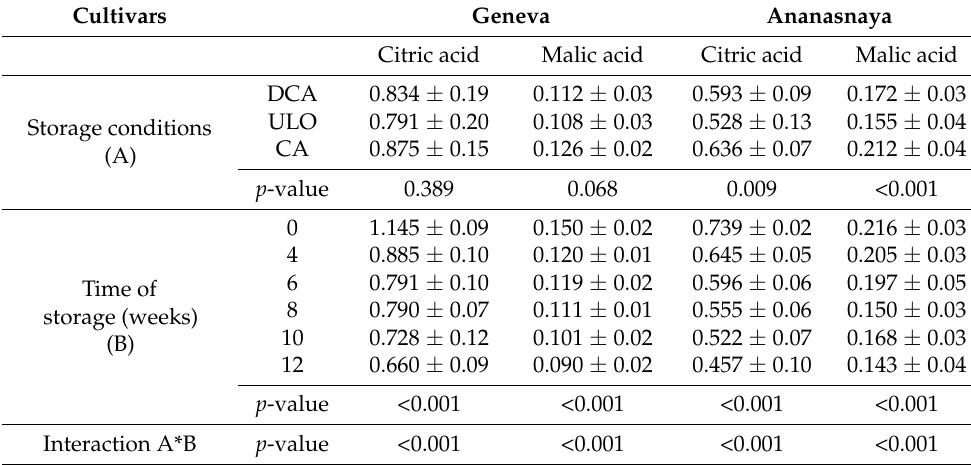
Table 6. Changes in citric acid and malic acid contents (g · 100 g − 1 F.W.) measured in ‘Geneva’ and ‘Ananasnaya’ minikiwi fruit in the postharvest period in 2017. Cultivars Geneva Ananasnaya